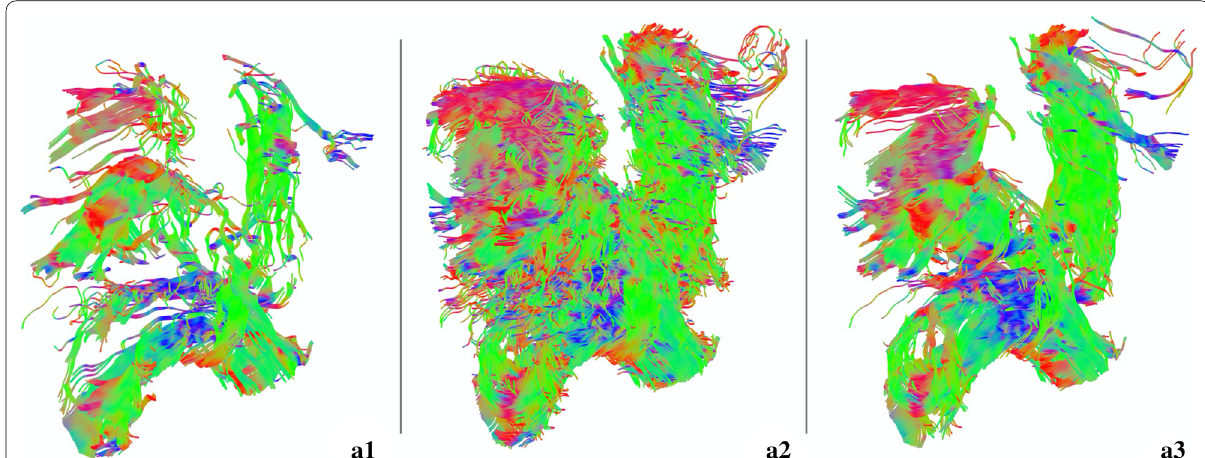
Fig. 4 Comparison of different thresholds for DTI fiber tractography in the prostate and surrounding areas of a 61-year-old prostate cancer patient. Fiber tractography results generated using the following combinations of FA thresholds and angular thresholds: 0.25 with 75º ( a1 ), 0.15 with 75º ( a2 ), and 0.15 with 50º ( a3